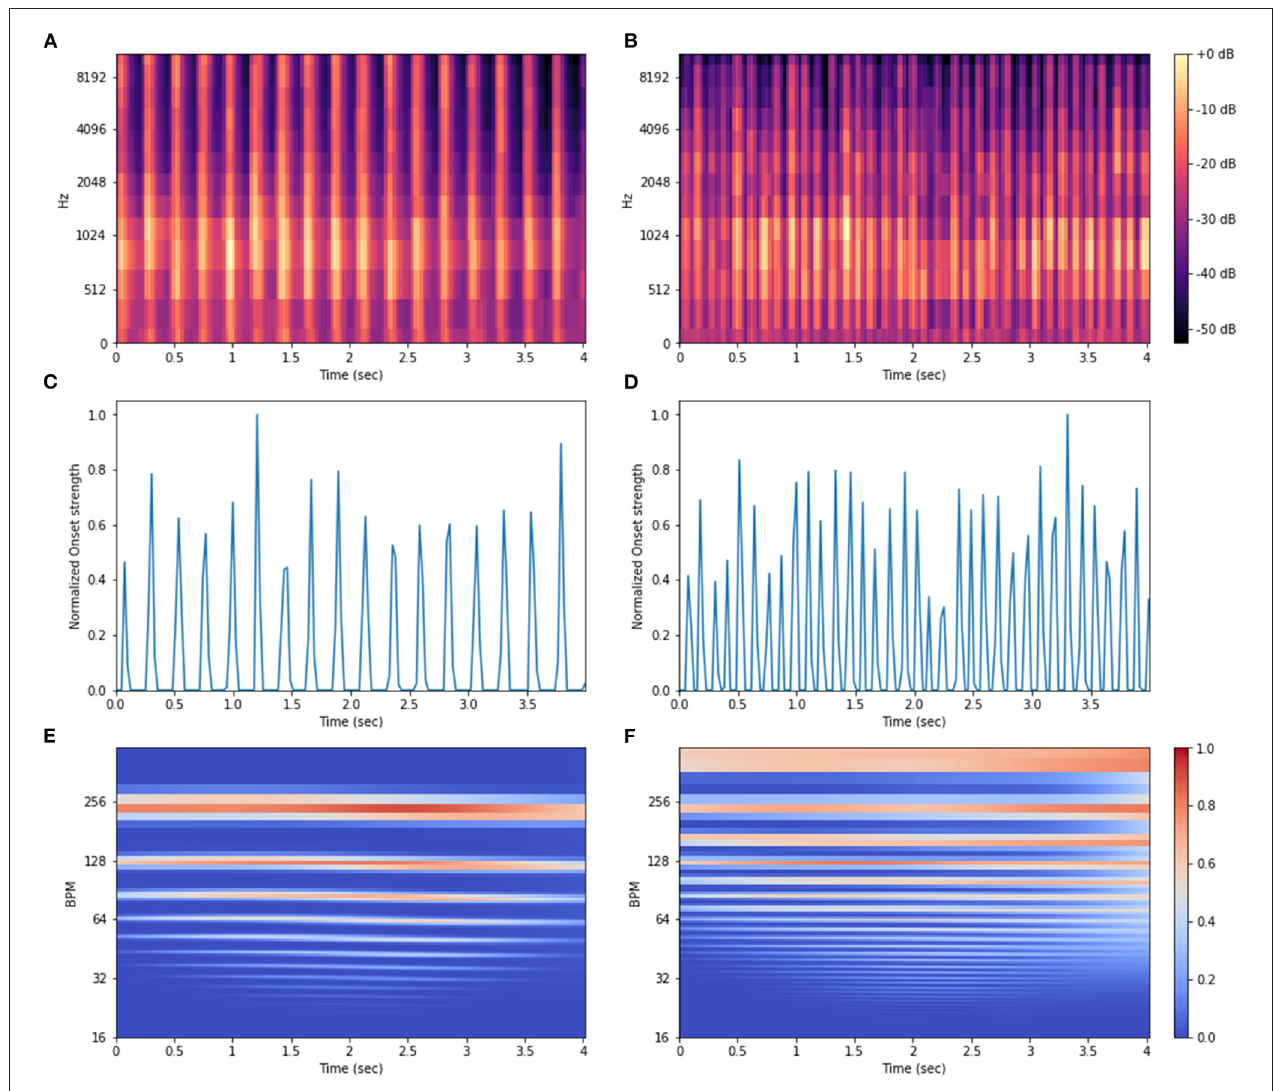
FIGURE 6 | Visual representation for the Mel-frequency cepstrum coefficients (MFCC) spectrogram (A,B) , Onset Strength envelope (C,D) , and Tempogram (E,F) extracted from audio recordings of Brazilian horses gaiting according to two gait types, marcha batida —MB (left) and marcha picada —MP (right).